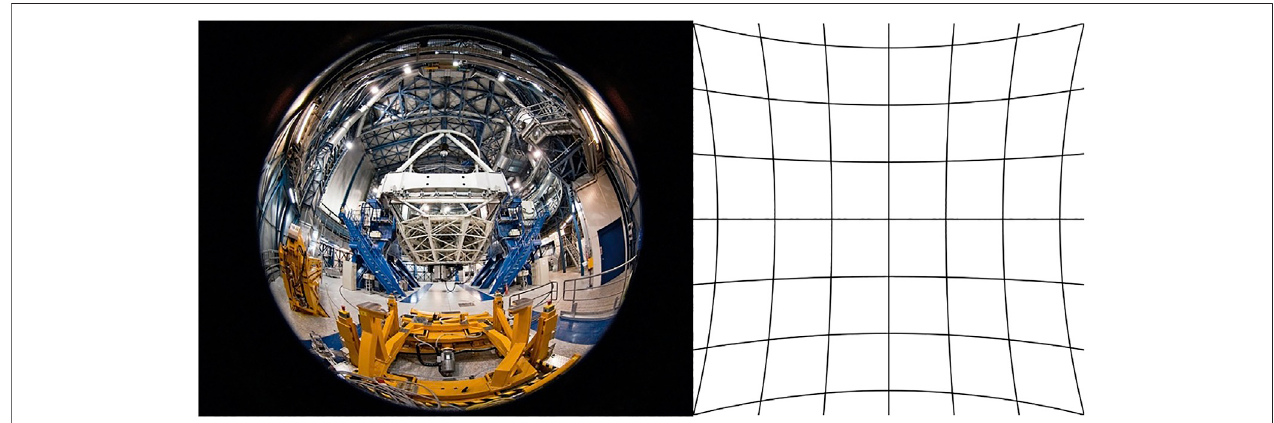
FIGURE 4 | Left: Image taken with wide angle lens demonstrating barrel distortion. Credit ESO/José Francisco Salgado. Right: Grid demonstrating pincushion distortion. Credit: